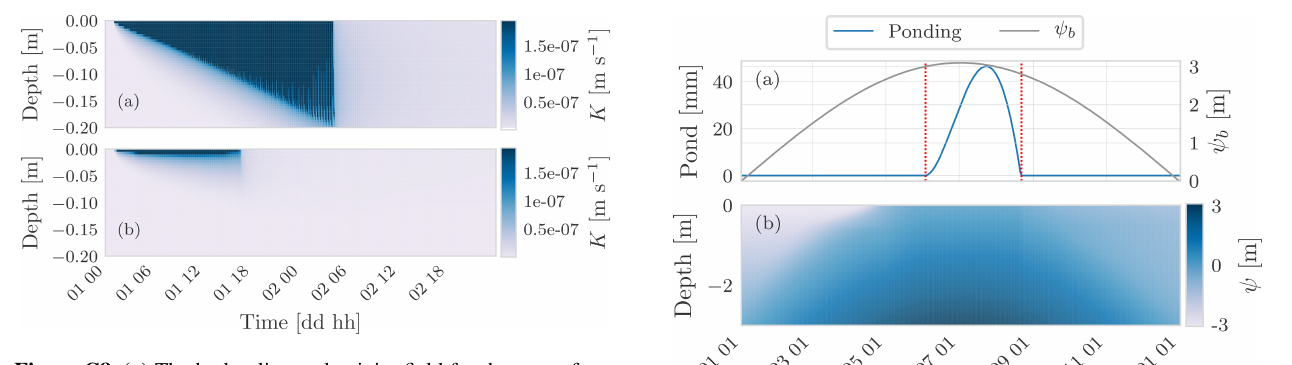
Figure C8. (a) The hydraulic conductivity field for the case of wet soil and (b) the hydraulic conductivity field for the case of dry soil.